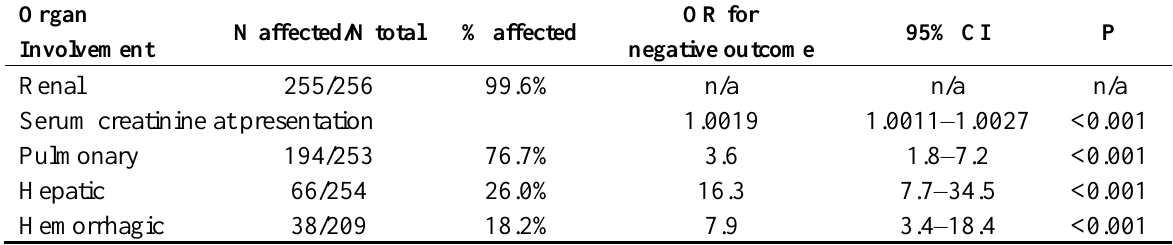
Table 1. Main organ system manifestations in 256 dogs diagnosed with leptospirosis between 2007 and 2012 and univariate odds ratios (OR) for negative outcome (death or euthanasia).